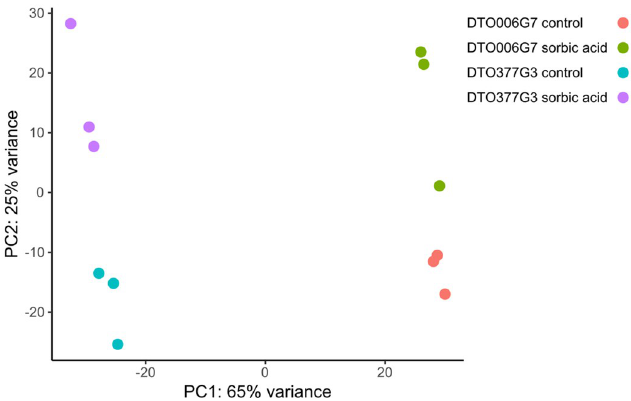
Fig 6. Principle component analysis demonstrates clustering of sorbic acid-exposed strains. Each dot represents a biological replicate. PC1 and PC2 together describe 90% of the variation. The sample grown on sorbic acid separate on the Y-axis and the two strains are separated on the X-axis.